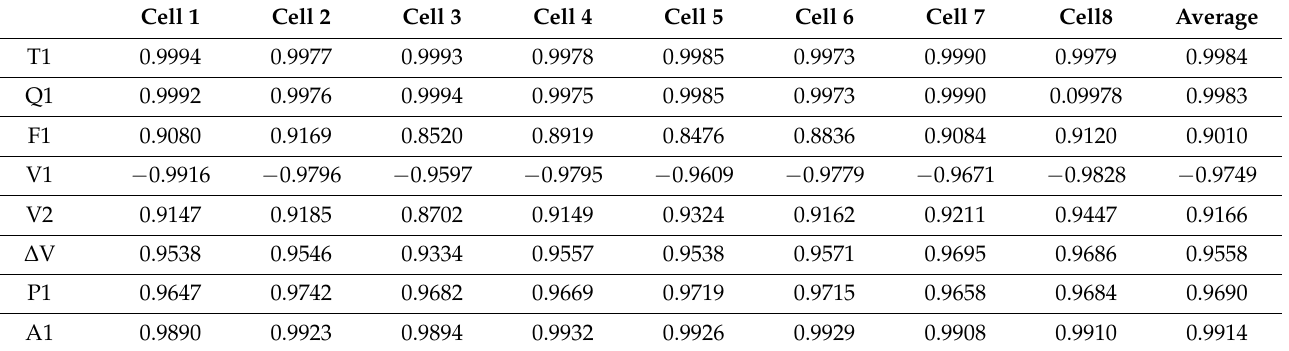
Table 2. Correlation analysis results.